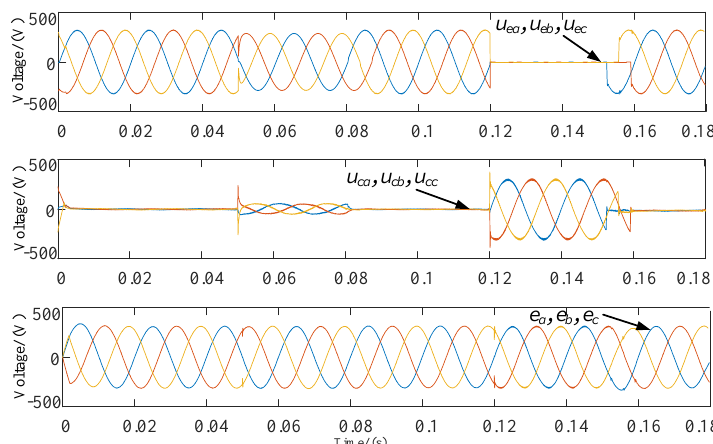
Figure 19. Dynamic voltage compensation simulation results of the series converter. Figure 20 is the dynamic synchronizing process of the microgrid interface. After 0.3 s, the output voltage of the renewable energy interface is the same as the grid voltage in the amplitude and phase. The results show that the renewable energy interface can connect to the grid within 0.3 s.